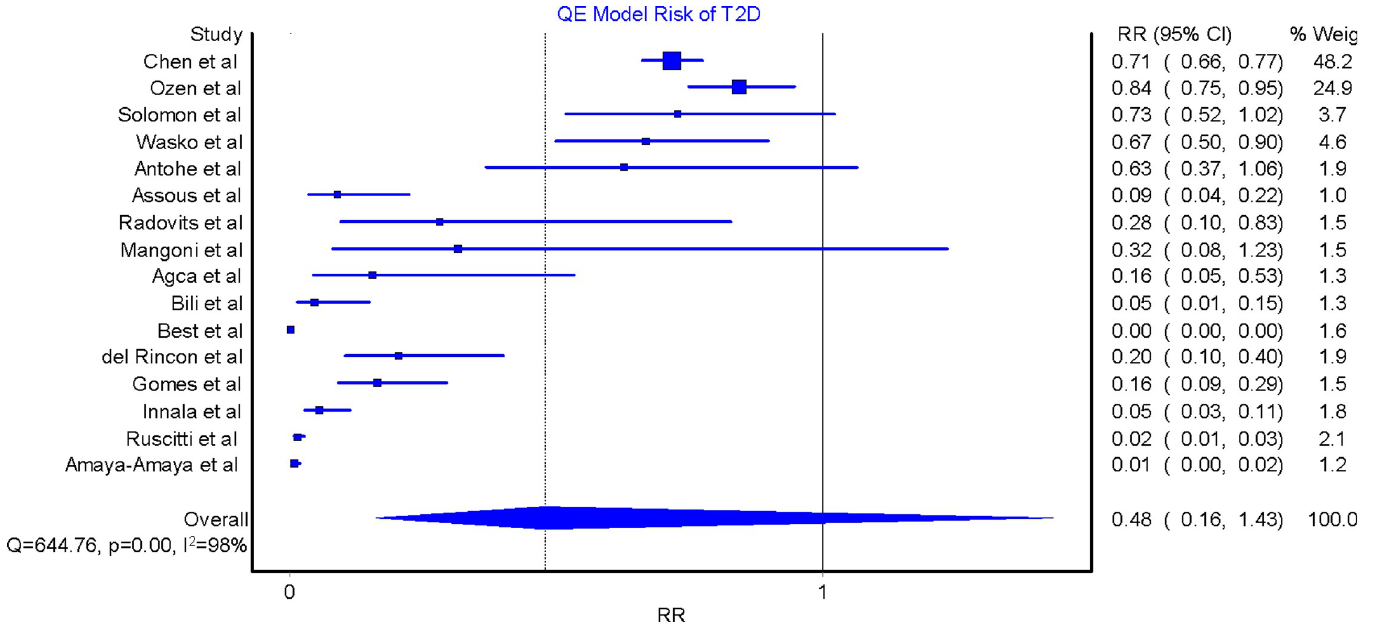
Fig 2. Relative risk of type 2 diabetes in rheumatoid arthritis patients on methotrexate versus those not taking methotrexate. QE = quality effects model; RR = relative risk; T2D = type 2 diabetes.